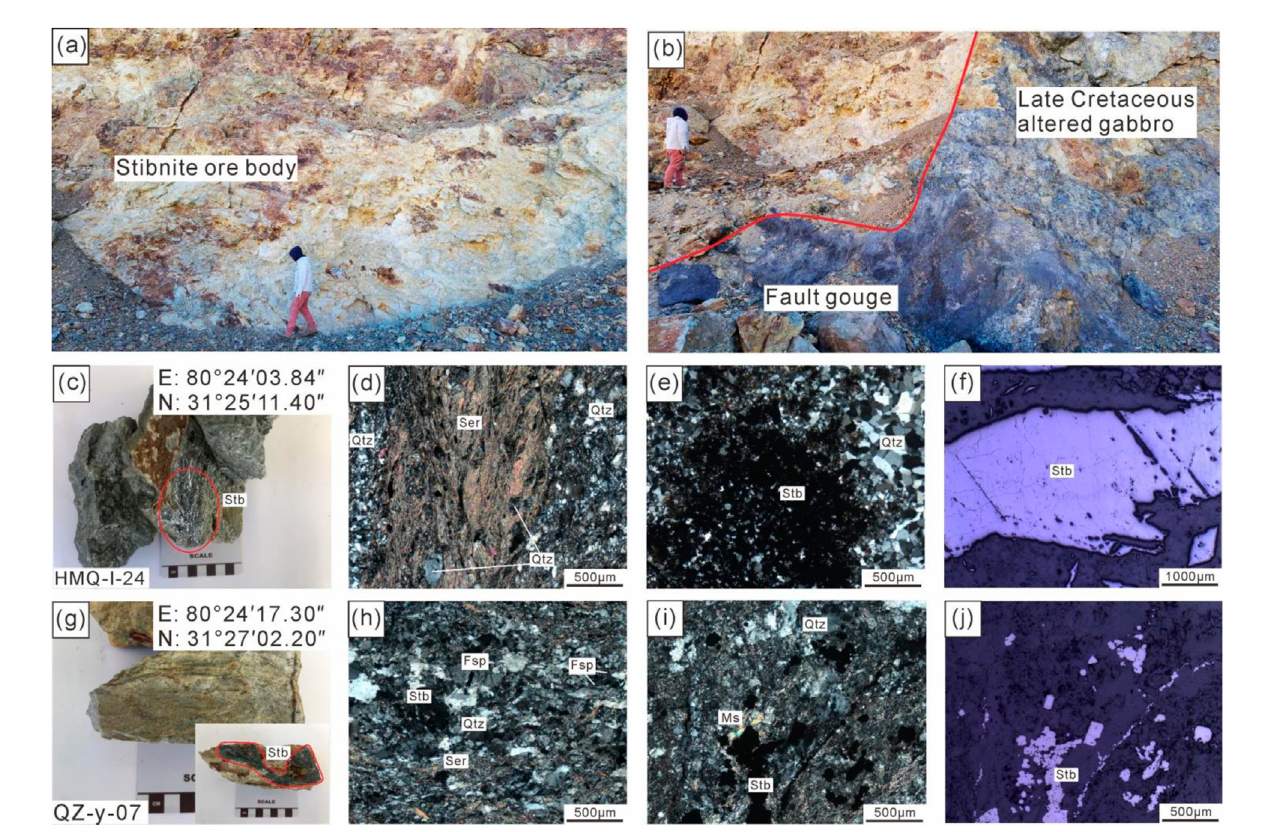
FIGURE 4 Field, hand specimens and microscopic photos of the Hamqu and Quzhen antimony de-posits (A) : fi eld photo of Hamuqu I orebody; (B) fi eld photo of Quzhen I orebody, the orebody is in contact with the fault zone and the late Cretaceous altered gabbro (K2 υ ); (C – F) : hand specimens and microscopic photographs of dark gray sericite silty slate in the Hamuqu deposit; (G – J) : hand specimens and microscopic photographs of greyish-green phyllitization sericeous slate in the Quzhen deposit; Qtz: quartz; Ser: sericite; Ms: muscovite; Fsp: feldspar; Stb: